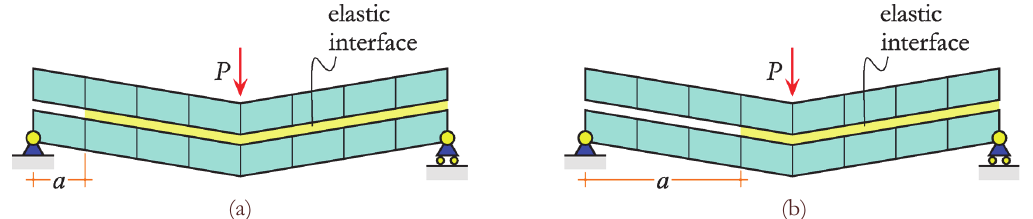
Figure 4: Elastic-interface model of the ENF test: deformed shapes due to shear for (a) shorter and (b) longer delamination cracks. Preliminary